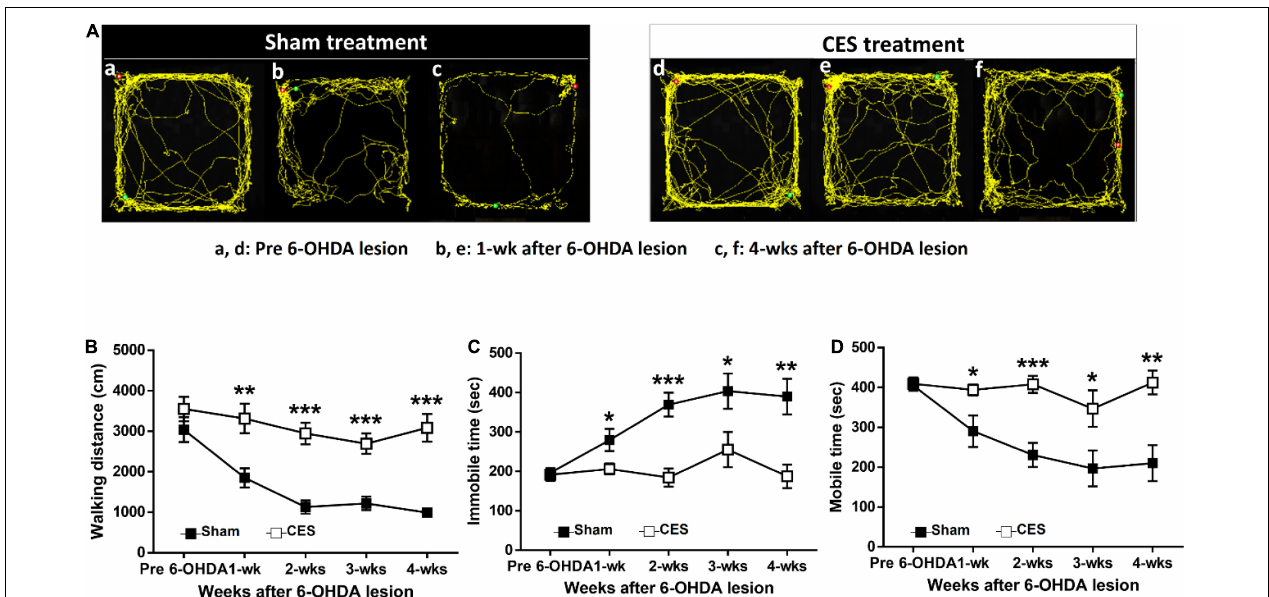
FIGURE 4 | Time-course analysis of locomotor activity assessed by open-field test at before and after 6-OHDA lesions. (A) Representative traces of rat movement patterns during the open-field test in the sham- and CES-treaded rats before PD lesions and at postlesion weeks 1 and 4. (B) Significant differences were observed between the sham and CES treatment groups in walking distance, (C) immobile time, and (D) mobile time after PD lesions. Values are expressed as the means ± SEMs. * p < 0.05, ** p < 0.01, and *** p < 0.001; each indicates a significant difference between the two